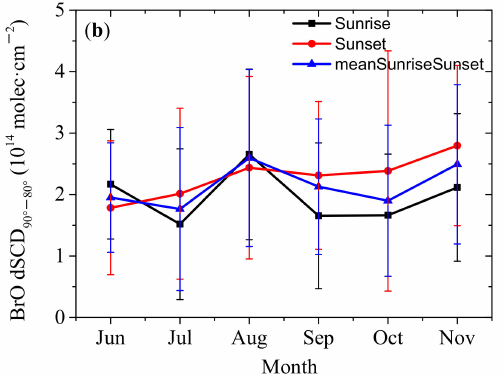
Figure A2. Same as the Figure 11, but the BrO dSCDs between 90 ◦ and 80 ◦ SZA are derived from a linear fit of BrO dSCDs for only 90 ◦ elevation